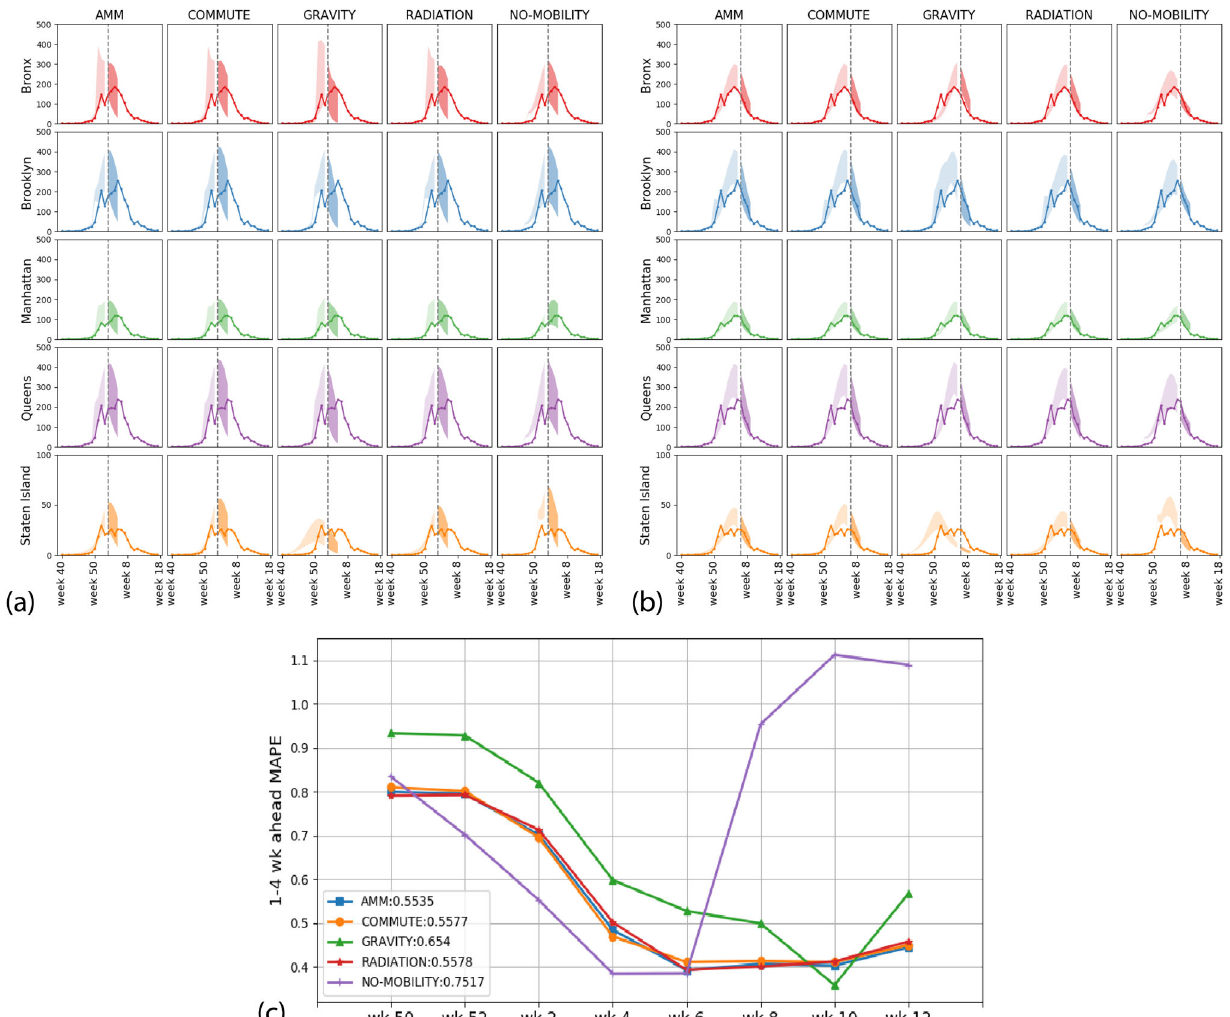
Fig. 4 Prediction envelopes and comparative forecast performance. The fi gure shows the comparative performance of the fi ve models in predicting emergency department visits in the fi ve boroughs of New York City. a , b show the calibration envelope (light shaded) and 90% prediction envelope (dark shaded) at weeks 2 and 6 of 2017, respectively. These weeks were chosen to be roughly two weeks pre-peak and two weeks post-peak across boroughs. The solid lines show the ground truth, and colors throughout are representative of boroughs. The plots are arranged horizontally by boroughs and vertically by the mobility network. c MAPE performance. One-to-four-week-ahead median predictions at different data horizons are used to evaluate the mean absolute percentage error (MAPE), for every other week of the fl u season. Note that the lower the MAPE, the better the network. The overall MAPE is provided in the legend shows that AMM, COMMUTE, and RADIATION models perform similarly, and do better than the GRAVITY or NO-MOBILITY